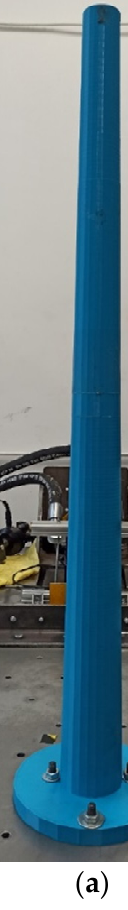
Figure 12. ( a ) The 3D printed polymer model of the chimney shaft made of PLA-IMPACT material; ( b ) the detail of the model with the lamination direction visible.